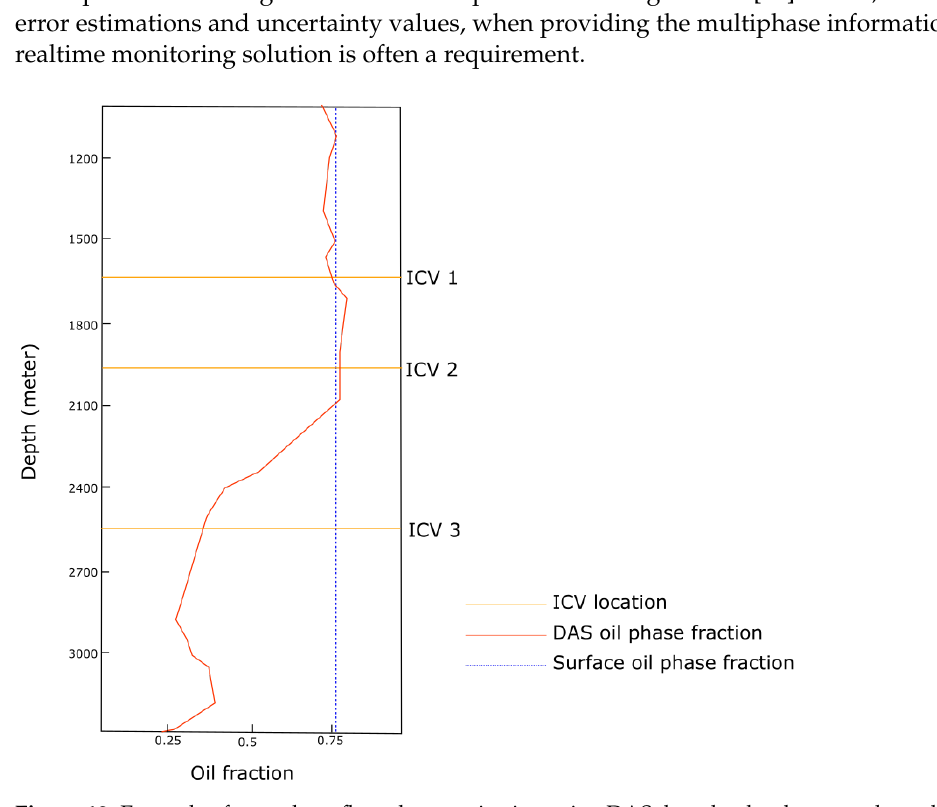
Figure 10. Example of two-phase flow characterisation using DAS data that has been used to calculate the oil fraction. The figure also shows the location of the